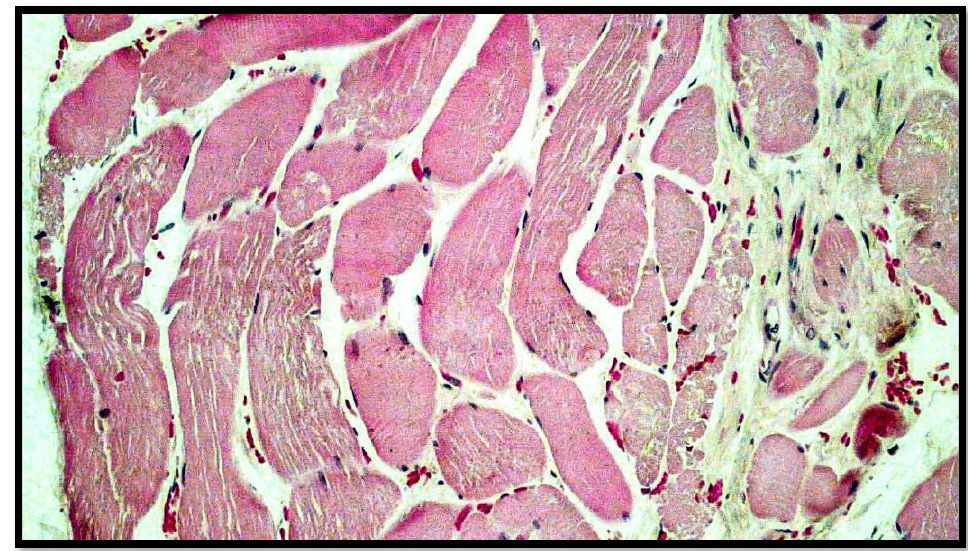
Figure 6. Routine preparation showing, at higher magnification, the presence of extravasated red blood cells between the striated muscle fibers, and the presence of connective tissue between the muscle fibers (hematoxylin–Eosin, Diapath S.p.A.). Original magnification, 20 ×